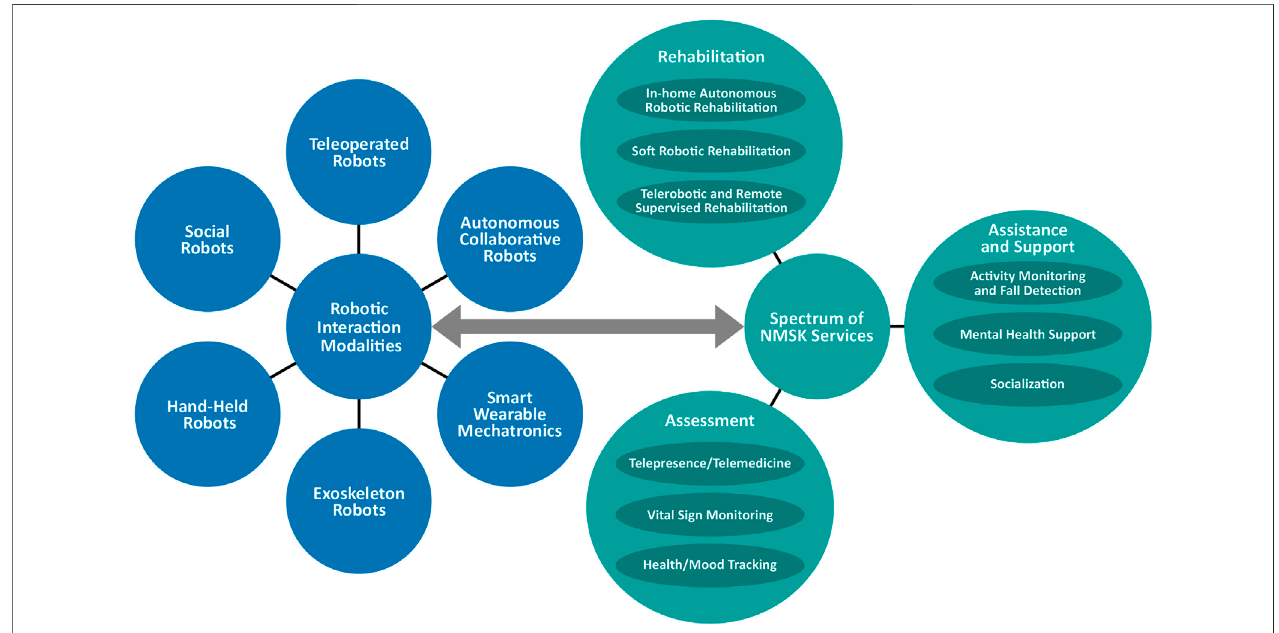
FIGURE1| Categories ofrobotic interactionand exampleremote rehabilitation,assessment, assistance,and supporttasks foradults with neuro-musculoskeletal conditions.